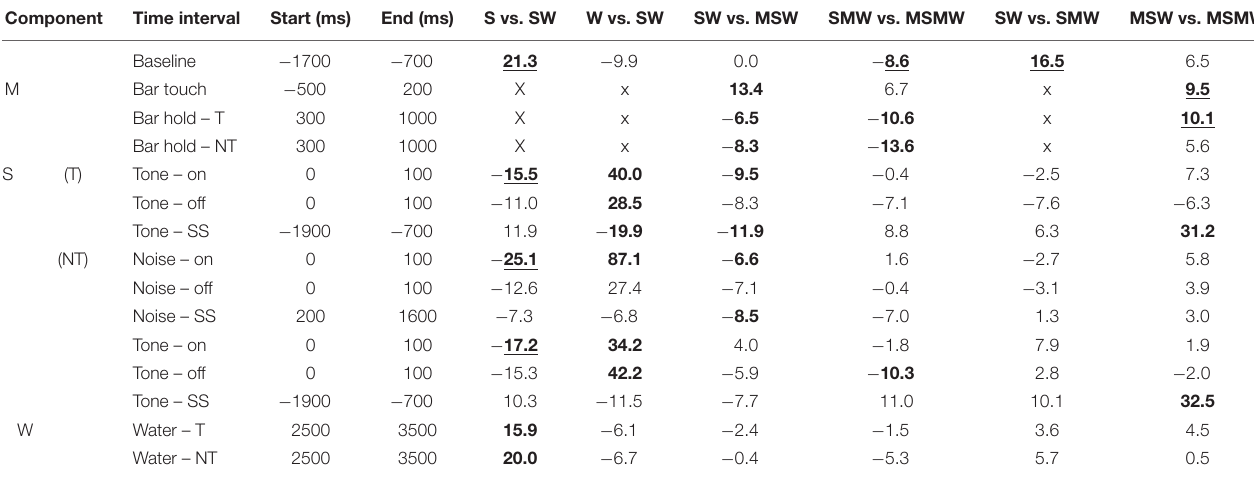
TABLE 1 | Median contrasts of the firing rates between experimental conditions in the instrumentally-trained monkeys.